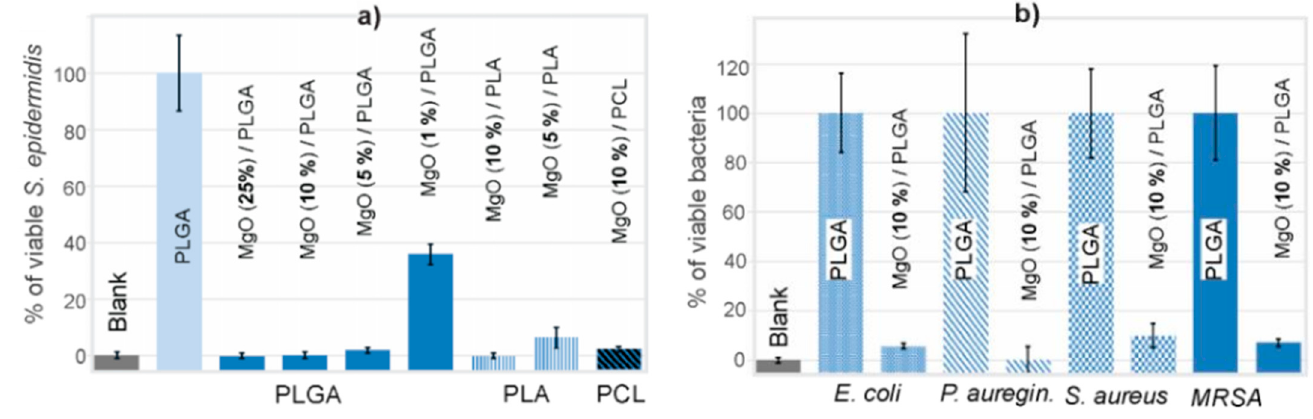
Figure 5. Relative metabolic activity of colonizing ( a ) S. epidermidis on the prepared MgO/polymer coatings and ( b ) E. coli , P. aeruginosa , S. aureus and MRSA on the MgO/PLGA coating. Blank sample is PLGA in sterile medium without bacteria.